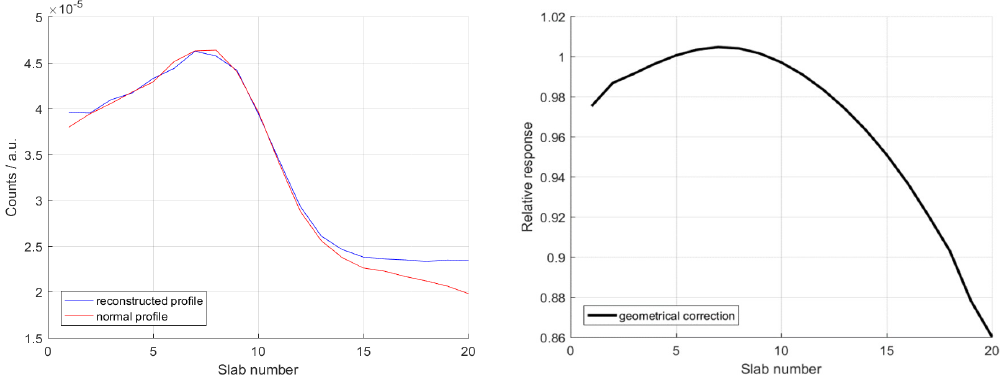
Figure 3. Left : Comparison between normal and artificially reconstructed profile, both simulated with MCNPX for 160 MeV, a geometry with 25:20 and no offset. Right : The corresponding geometrical correction function.